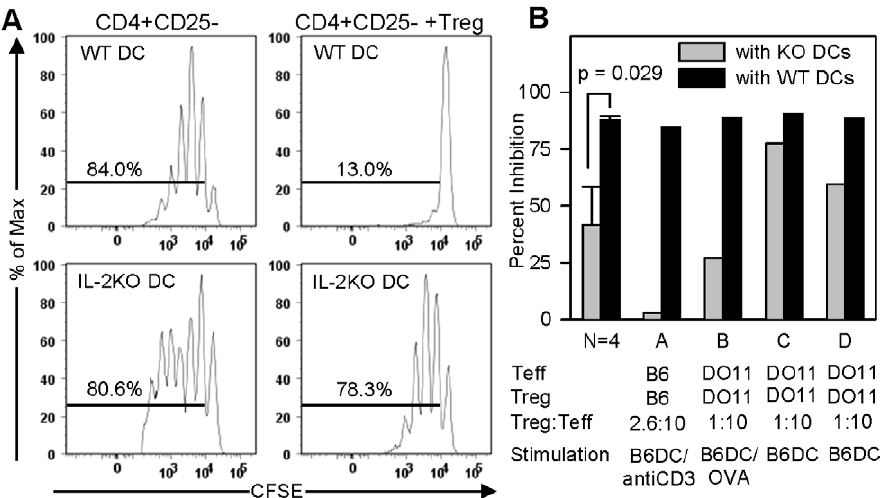
Figure 8. Dendritic cell IL-2 regulates Treg suppression of CD4 + proliferation. A: The Panels show proliferation of anti-CD3 stimulated CFSE-labeled C57BL/6 CD4 + CD25 2 Teff cells co-cultured with WT or IL-2 2 / 2 KO (on B6 background) BMDCs, with and without C57BL/6 Treg cells at a Treg:Teff ratio of 2.5:10. Numbers indicate percentage of Teffs that have divided. B: CD4 + CD25 2 Teff cell proliferation was measured by flow cytometry, and the % of Treg suppression of Teff cell proliferation was calculated as in materials and methods. Bars show percent Treg inhibition of proliferation of CD4 + CD25 2 Teff cells that were co-cultured with IL-2 2 / 2 KO (gray) or WT (black) B6 BMDCs and Tregs at Treg:Teff ratio of 2.5:10 (A) or 1:10 (B–D), and stimulated as specified in columns A–D and materials and methods.